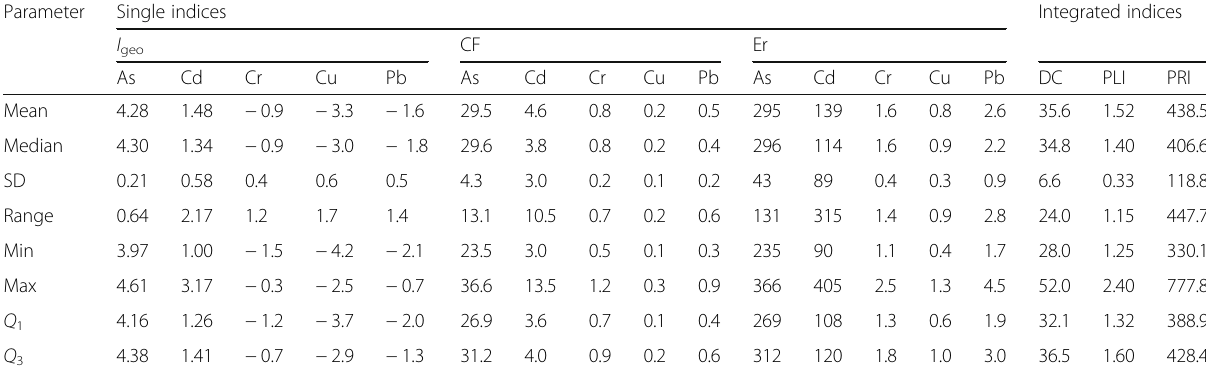
Table 4 Summary statistics of I geo , CF, Er, DC, PLI, and PRI for the determined elements Parameter